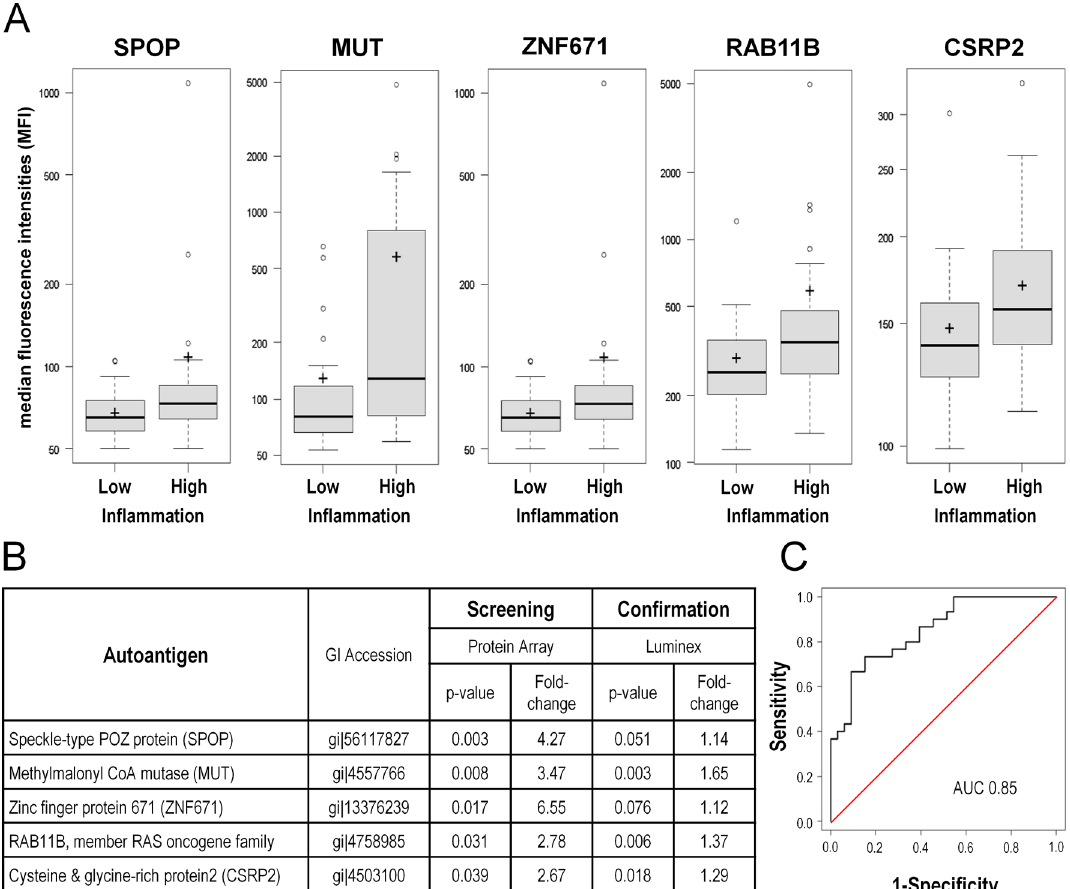
Fig 3. Cross-validation of identified autoantibody profile using a Luminex-beads protein array. The identified profile was validated in an independent set of prostate cancer patients (n = 60) using the bead-based Luminex technology to identify autoantibodies. A Box plots of mean fluorescent intensities (MFI) values for the five top autoantibody candidates significantly increased in the prostate high inflammation group in both screens. B Table displaying fold- change and p-values of the autoantibodies significantly upregulated in high-inflammation serum samples of the screening and validation patient cohorts. C ROC curve for the top five autoantibodies for the classification of samples of the validation set. The identified biomarker profile discriminates between high and low inflammation patients with an AUC of 0.85.